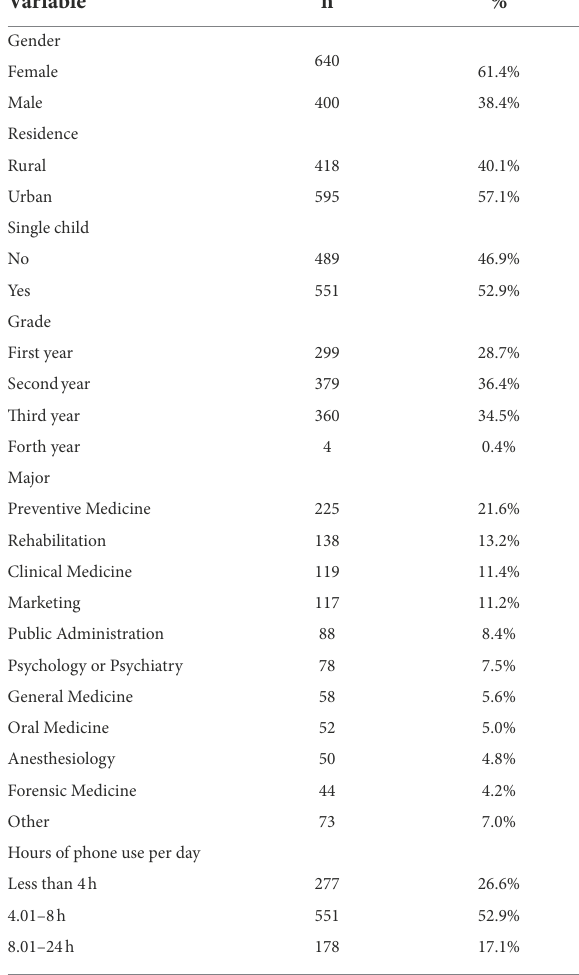
TABLE 1 Demographic characteristics of the participants ( n = 1,042).